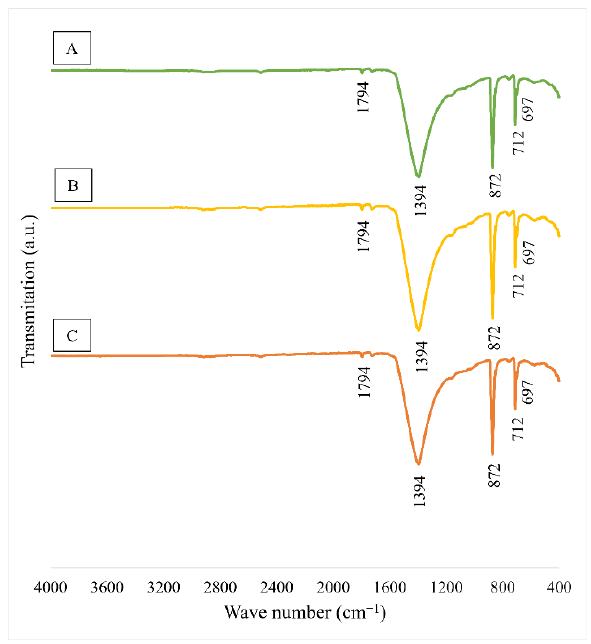
Figure 2. FT-IR spectra of tested materials ( A — sample A, B — sample B, C — sample C).